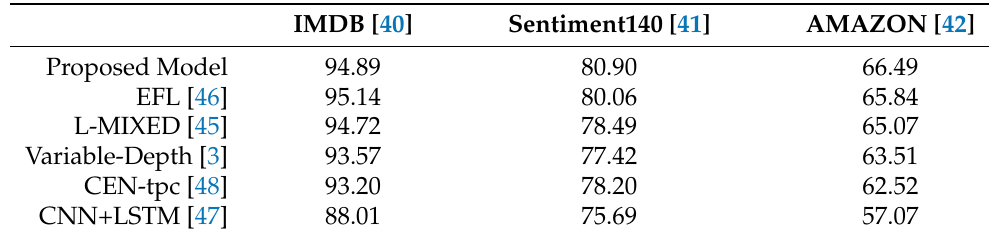
Table 3. Comparison with other state-of-the-art methods. Bold values are used to emphasize that the model can achieve better accuracy